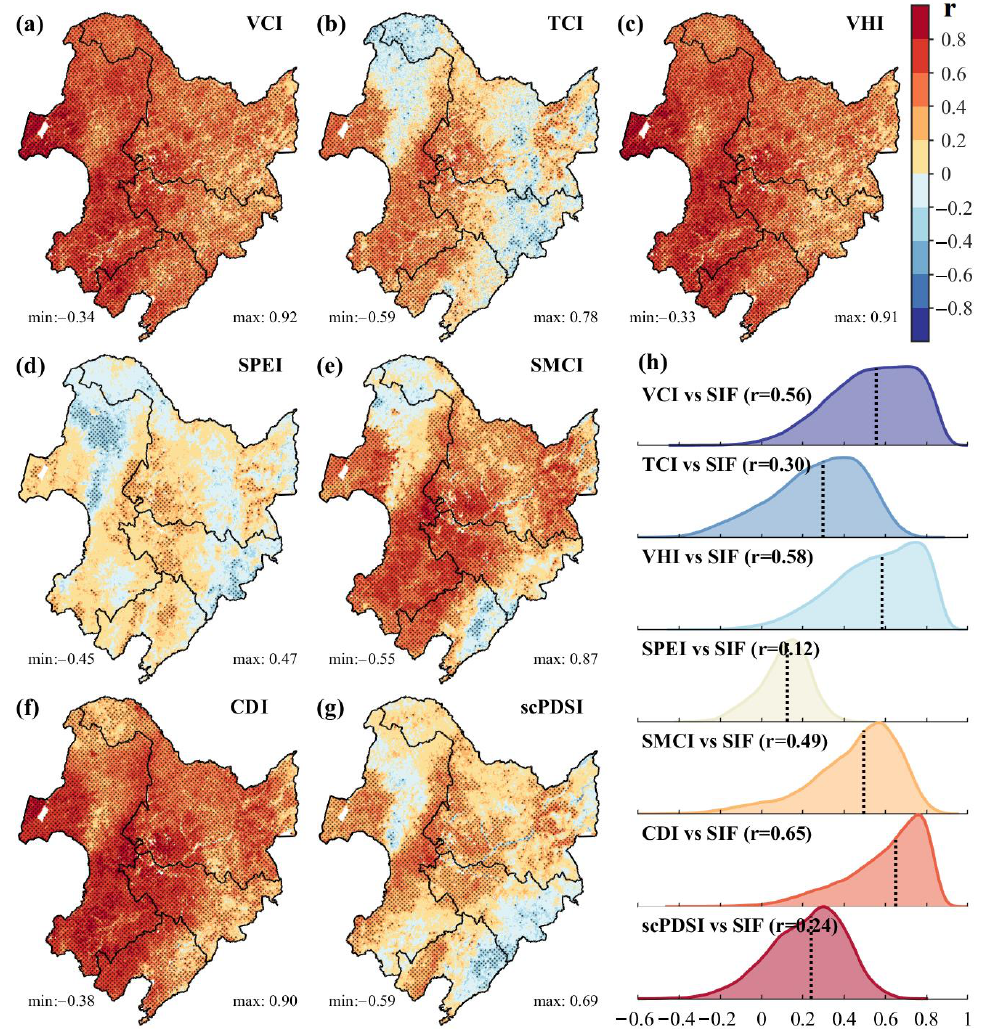
Figure 4. Correlations ( a – g ) and statistics ( h ) of different drought indices with SIF in NEC, 2000–2020. (Dotted areas indicate p < 0.05 significant correlations, dashed lines indicate median correlation coefficients of all grid points in farmland and grassland areas.)